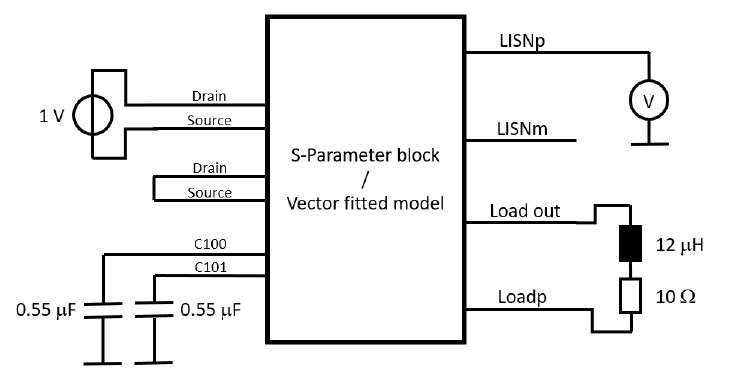
Figure 13. Block diagram for the Validation of the vector-fitted model.